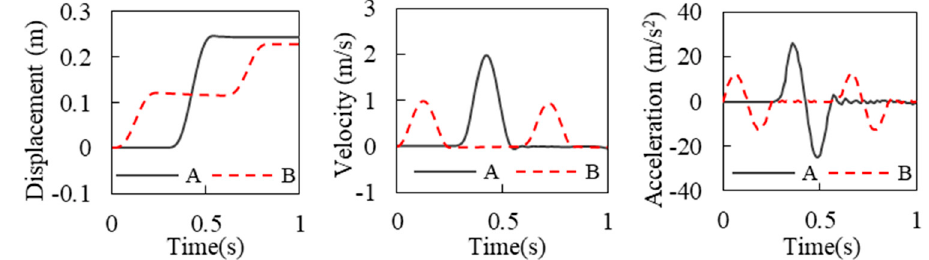
Figure 5. The time–history curves of horizontal displacement, velocity, and acceleration.